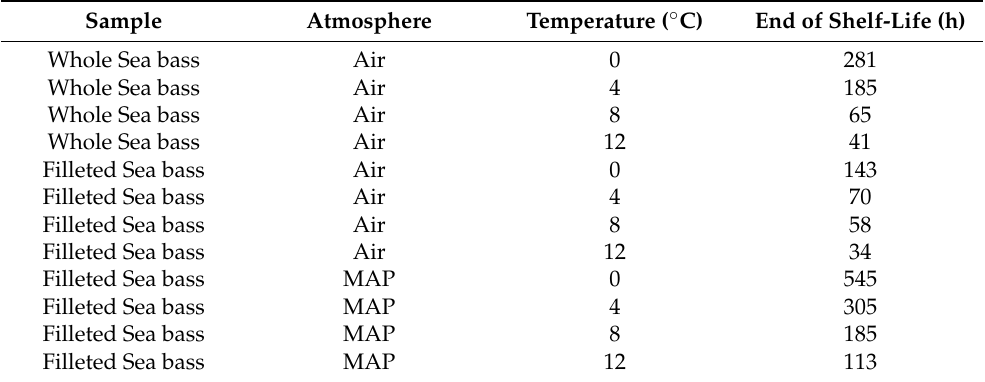
Table 2. Determination of products’ end of shelf-life, as assessed by sensory evaluation of five trained panelists.